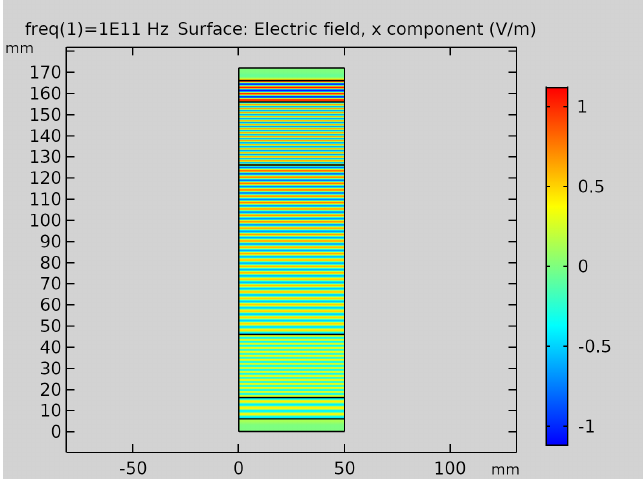
Figure 5. Electric distribution at 100 GHz of n e = 1.6 × 10 18 m − 3 and f e = 4.3 × 10 10